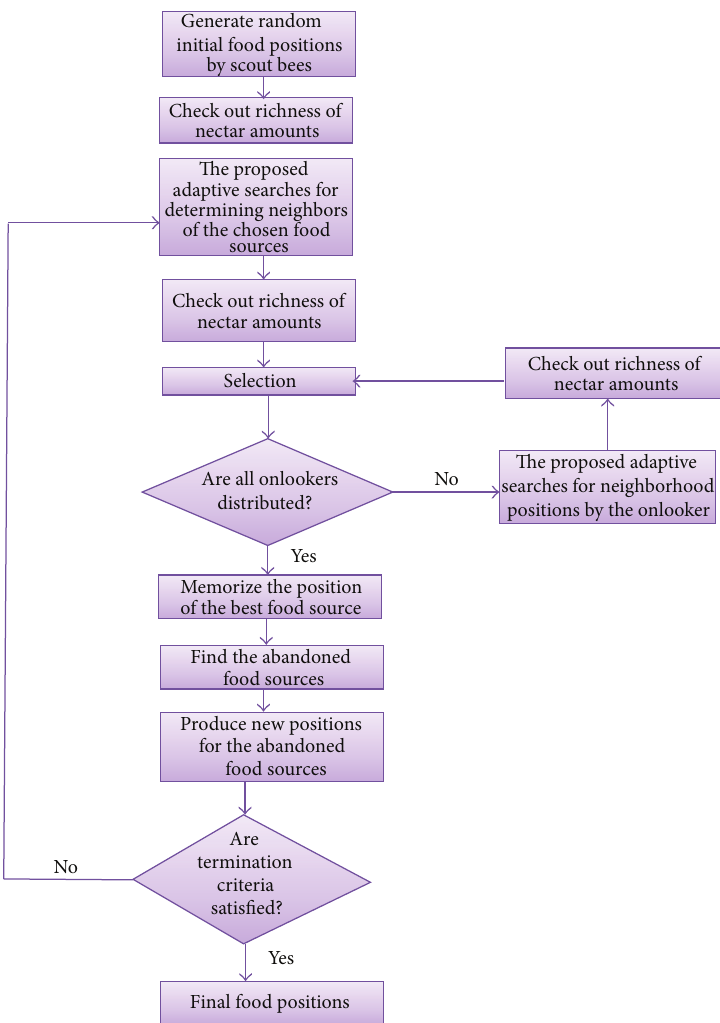
Figure 1: Adaptive ABC